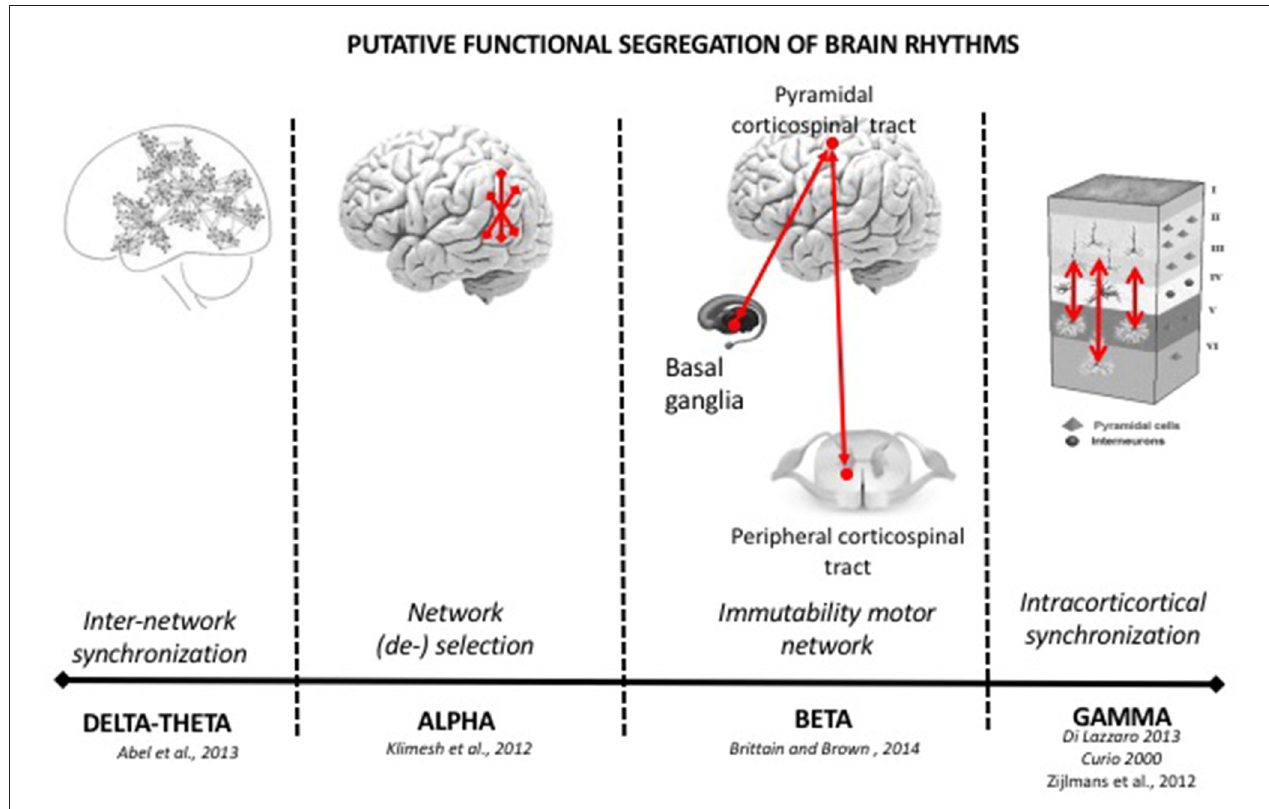
FIGURE 1 | Functional role of brain rhythms in healthy subjects. In healthy participants, brain oscillations are subsumed in specific canonical frequency band, with presumably different functions. Slower rhythms (delta-theta) are associated with higher power spectra generated by the synchronization of a big number of neurons or of networks of neurons. They prevail during sleep, when memory consolidation phenomena occur. The alpha rhythm is the dominant oscillation in the awake state has been associated with inhibitory functions to gate information flow. Beta activity is a rhythm of the motor system (pyramidal and extra-pyramidal) and inhibits the changing of motor activity. Gamma and higher oscillations are resident in intracortical activity synchronizing small group of neurons. See the text of manuscript for more